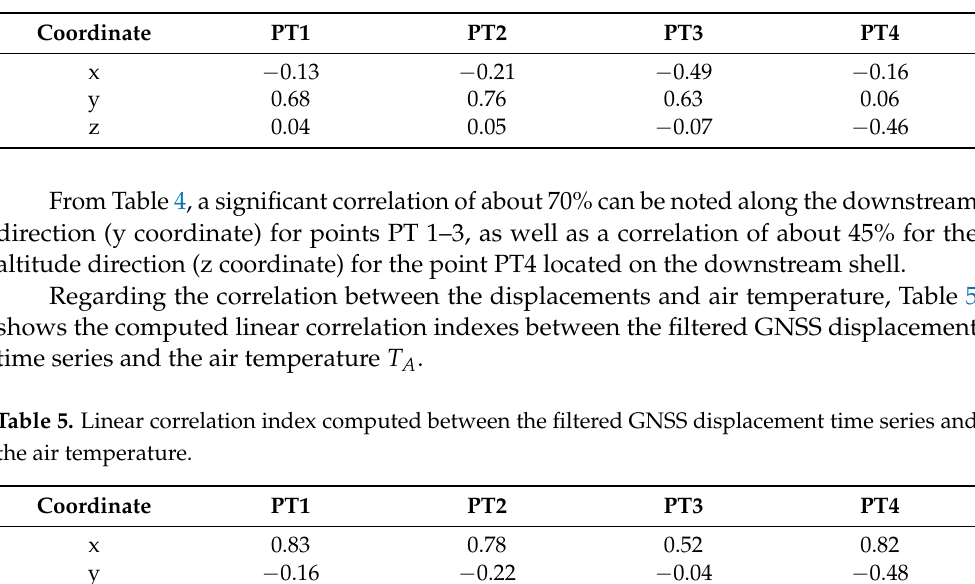
Table 4. Linear correlation index computed between the filtered GNSS displacement time series and the reservoir water level.